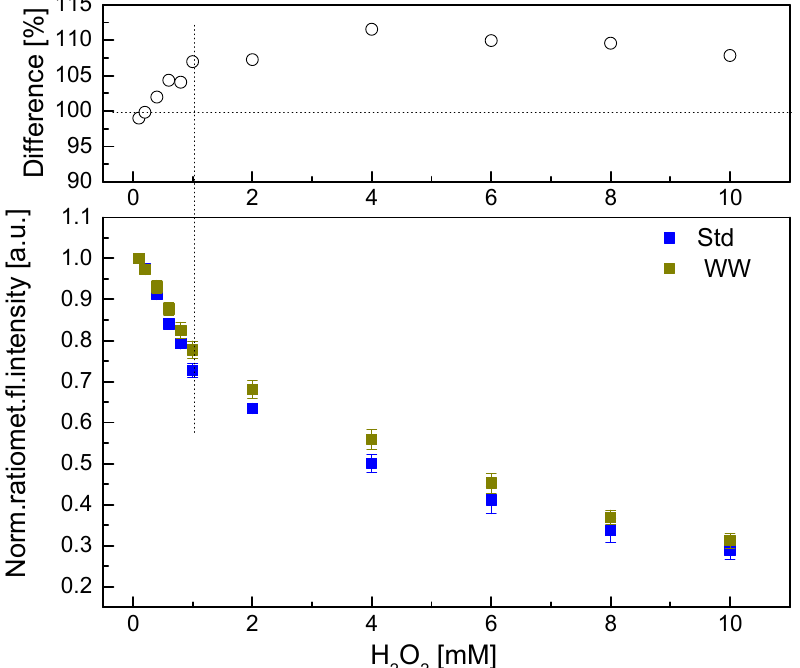
Figure 12. Recovery of the HRP–QD–AF membrane with different concentrations of H 2 O 2 in standard phosphate buffer solution (Std) and artificial wastewater (WW).